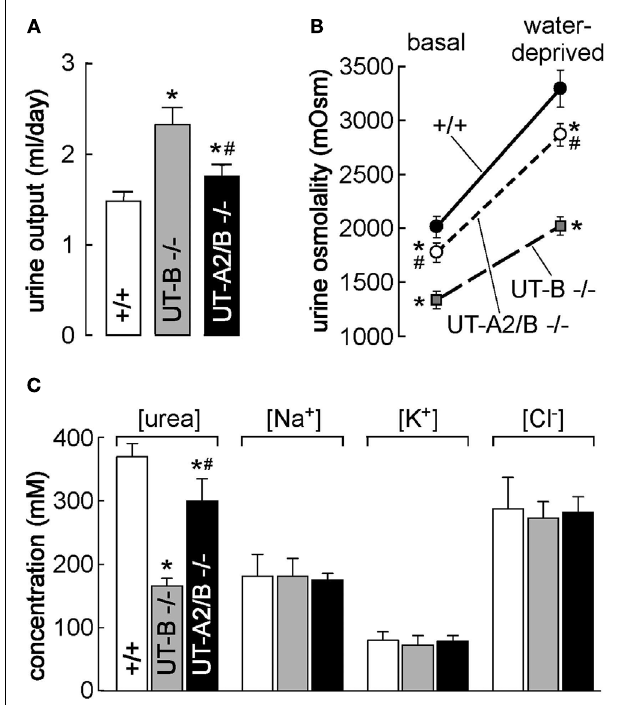
FIGURE 3 | Effect of acute urea loading on urinary concentrating activity and renal handling of urea inWT, UT-B KO, and UT-A2/B KO mice. Three-hundred micromolar urea were injected intraperitoneally just after the first 2h urine collection ( time 0 ), and urine was then collected for four more 2h periods. (A) Urine osmolality ( U osm ). (B) Urine output. (C) Urine urea concentration ( U urea ). (D) Plasma urea concentration P urea .Values are expressed as means ± SE, n = 6/group. *p < 0.01 compared withWT mice, # p < 0.01 compared with UT-B KO mice. Reproduced from Lei et al.